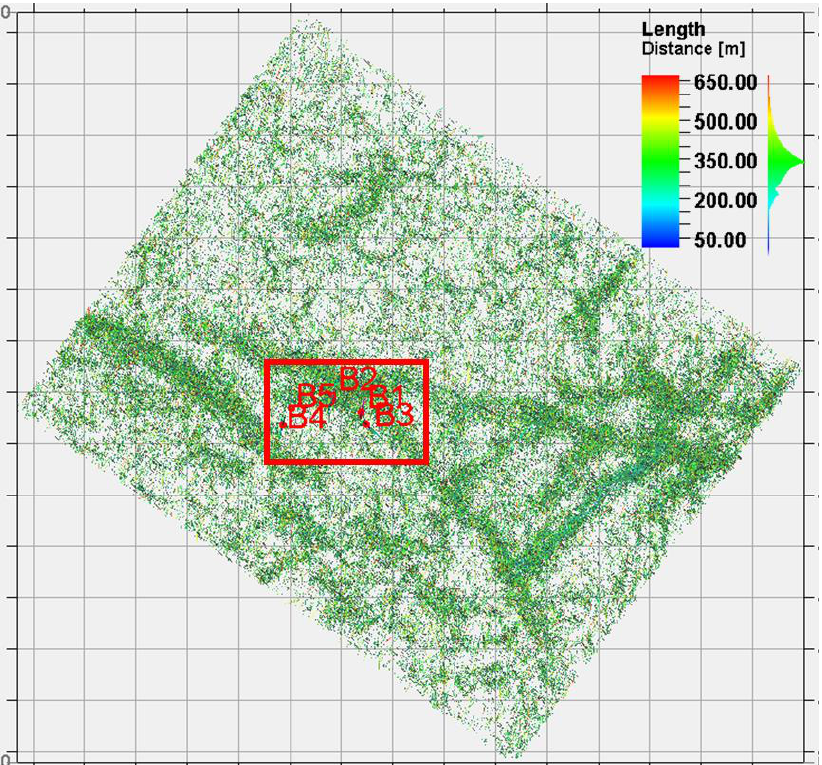
Figure 16. Full field DFN model for the entire reservoir, displaying the fractures lengths. The red square delimits the B-P gas model employed for the following water intrusion characterization. As reference, every coordinate grid block is 2000 × 2000 m.